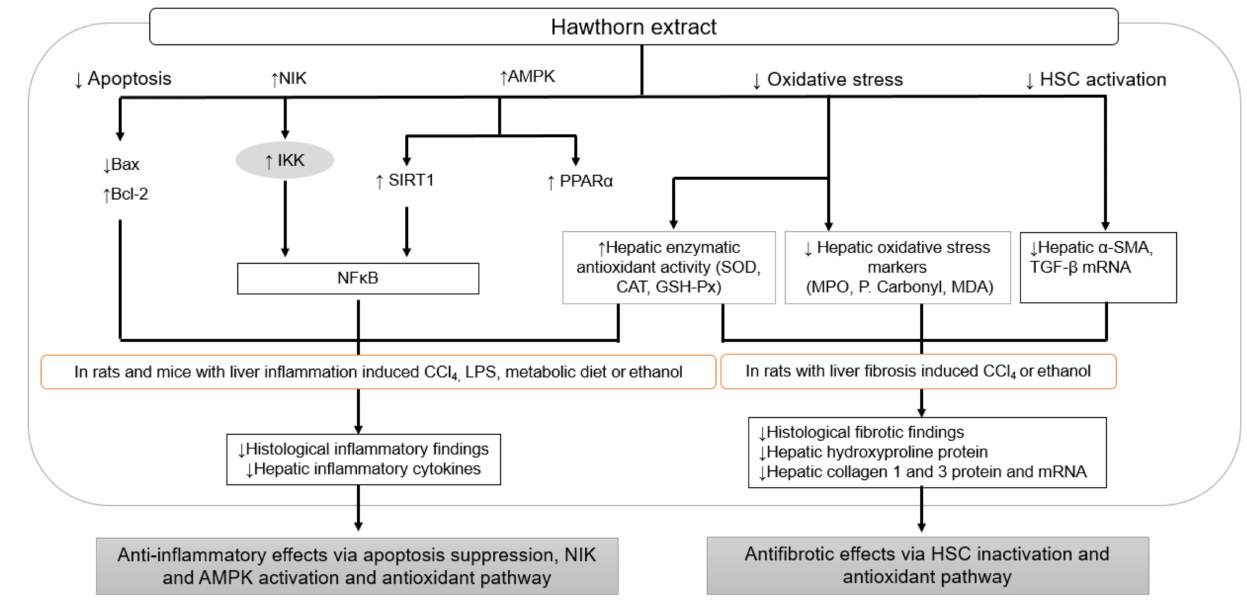
Figure 3. Anti-inflammatory effects and antifibrotic effects of hawthorn extract through apoptosis suppression, AMPK and NIK activation, HSC inactivation, and antioxidant defense system. AMPK, AMP-activated protein kinase; Bax, Bcl-2-associated X protein; Bcl-2, B-cell lymphoma-2; CAT, catalase; CCl 4 , carbon tetrachloride; GSH-Px, glutathione peroxidase; HSC, hepatic stellate cell;